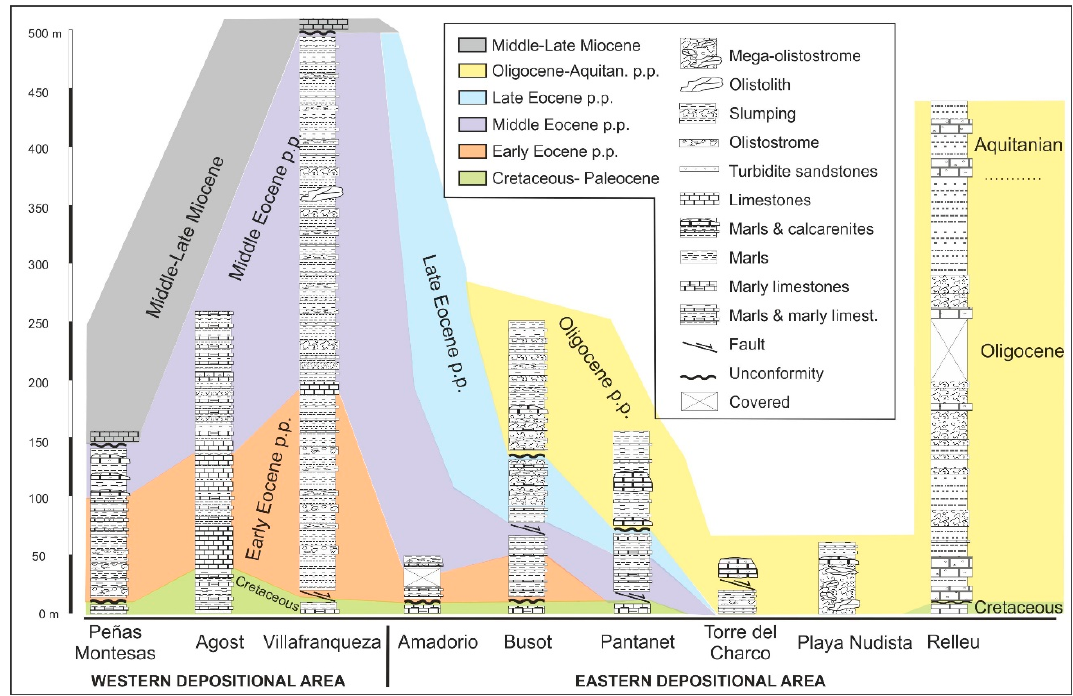
Figure 6. Stratigraphic columns and correlation of Paleogene-Aquitanian sediments of the Cenozoic Alicante Trough (Alicante sector) in the eastern EBZ (after References [15,18]; modified). Three stratigraphic sections are representative for the Western Depositional Area of the Alicante Trough (Peñas Montesas, Agost and Villafranqueza) and six stratigraphic sections for the Eastern Depositional Area of the same trough (Amadorio, Busot, Pantanet, Torre del Charco, Playa Nudista and Relleu).